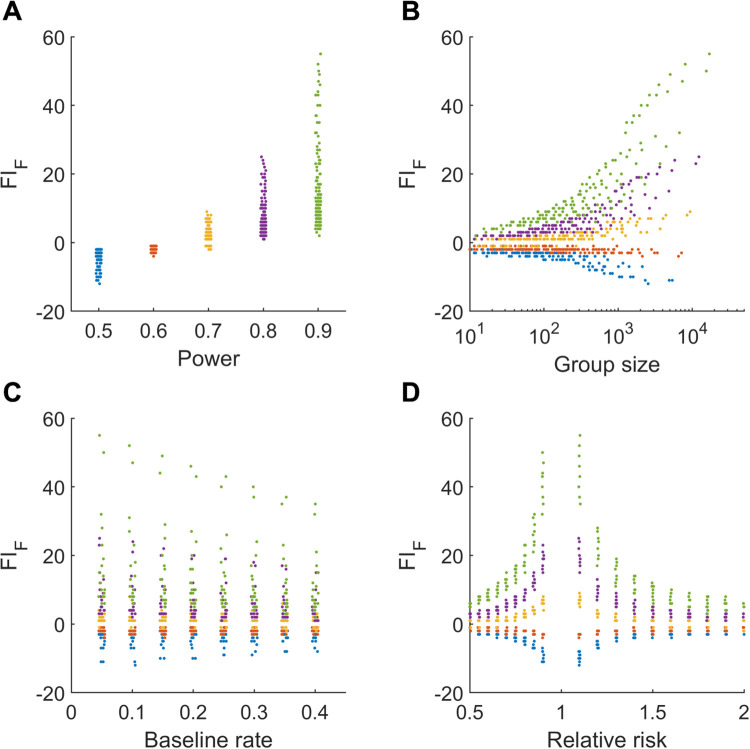
Sample size calculations and FI in simulated studies.(A) Scatterplot showing the relationship between FI and study power (1—β). (B) Scatterplot showing the relationship between FI and group size (half the total study size). The group size is shown on a logarithmic axis. (C) Scatterplot showing the relationship between FI and the baseline event rate in the comparator group. (D) Scatterplot showing the relationship between FI and relative risk. Colours represent power levels as in Panel (A).